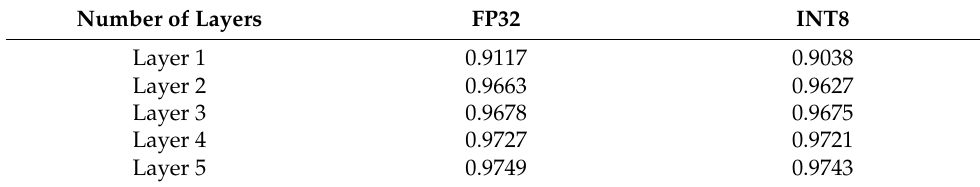
Table 2. Accuracy comparison between FP32 and INT8 in different layers with noise. Number of Layers FP32 INT8 Layer